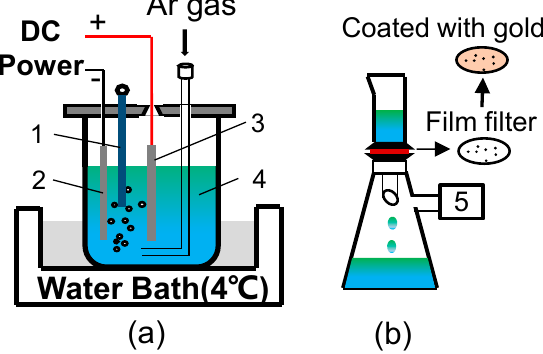
Figure 2. Schematic illustration of electrolytic process: ( a ) extraction; ( b ) filtration. 1. Thermometer, 2. Cathode, 3. Steel sample, 4. Electrolyte, 5. Vacuum pump.